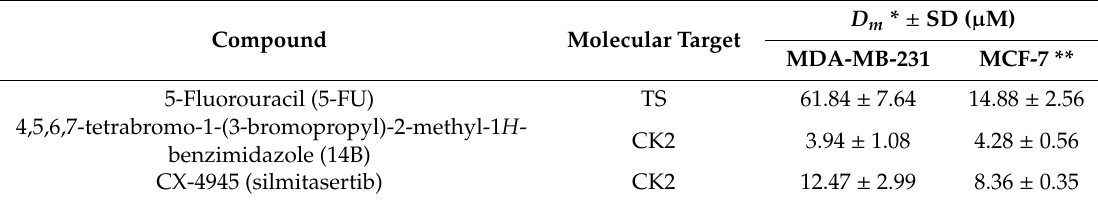
Table 1. The drug potency ( D m ) obtained after fitting the MTT-based assay data to the median e ff ect equation using the CalcuSyn